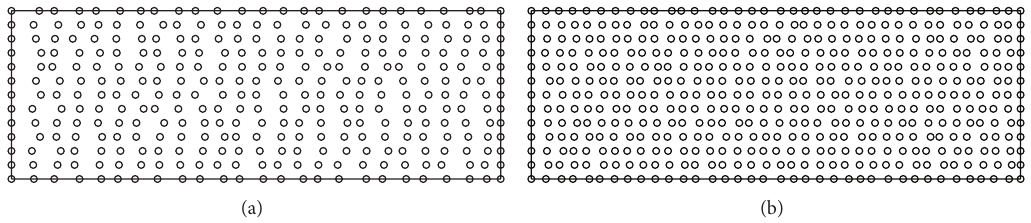
Figure 4: Meshless models with irregular data points: 325 nodes (a), 481 nodes (b).